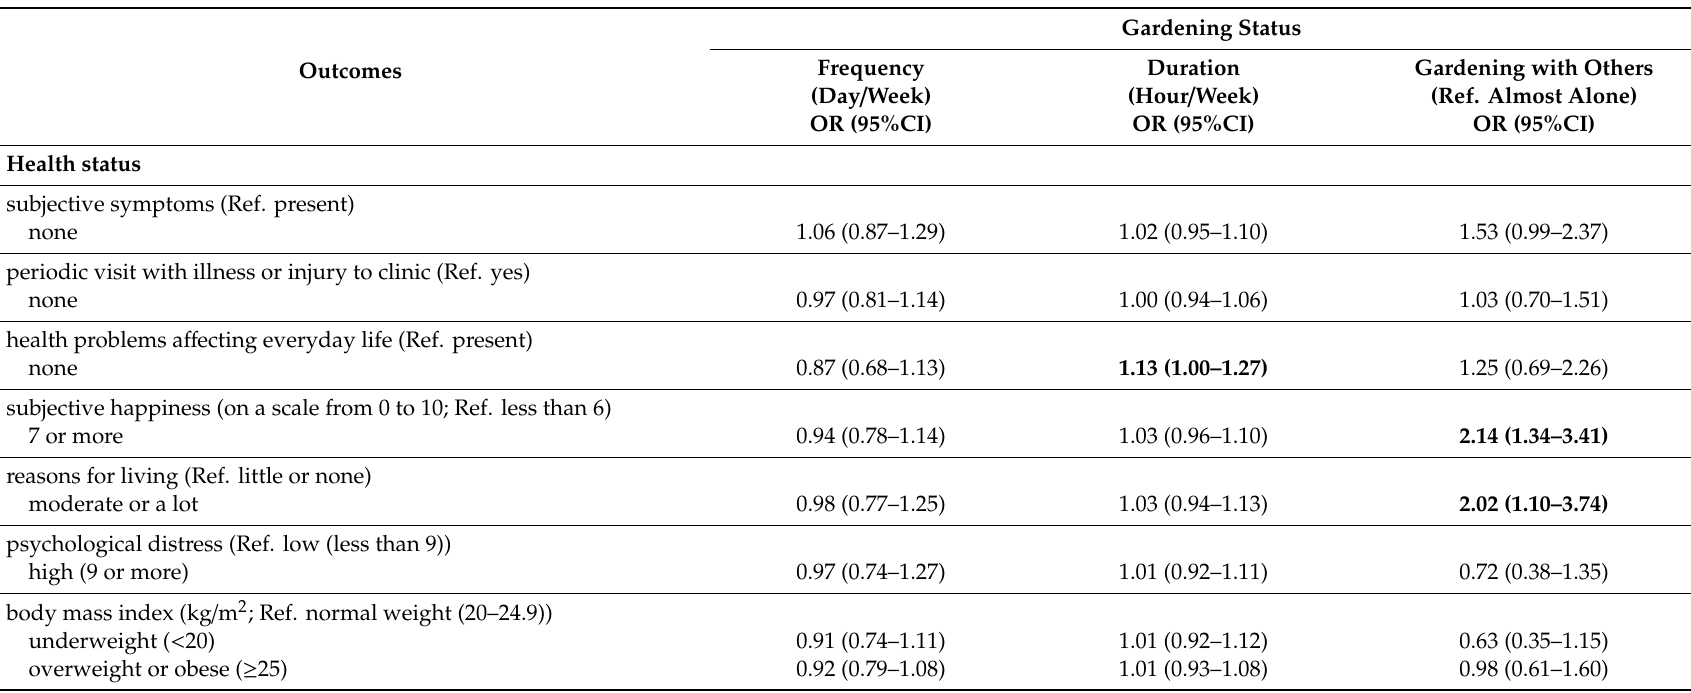
Table 3. Relationship between gardening status and health status or healthy